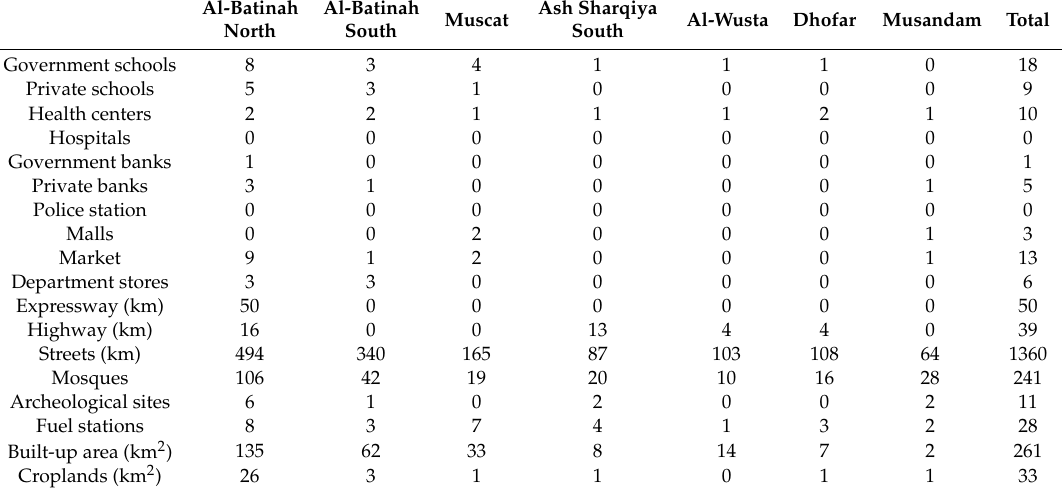
Table 6. The vulnerability matrix of the 8 m tsunami scenario at the governorate level. Al-Batinah Al-Batinah North South